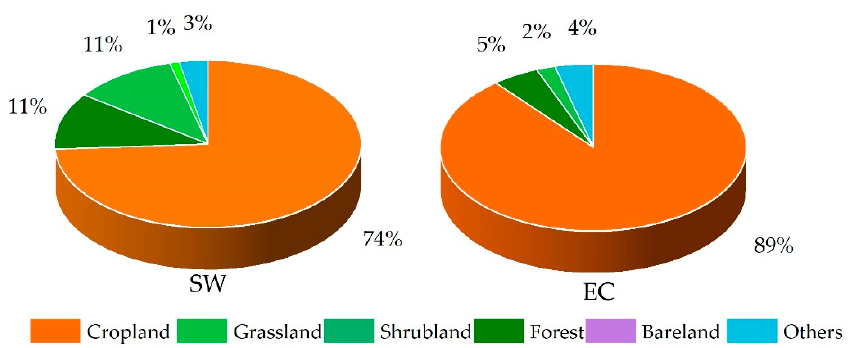
Figure 13. Proportion of artificial surfaces converted from the different land cover types in SW and EC.